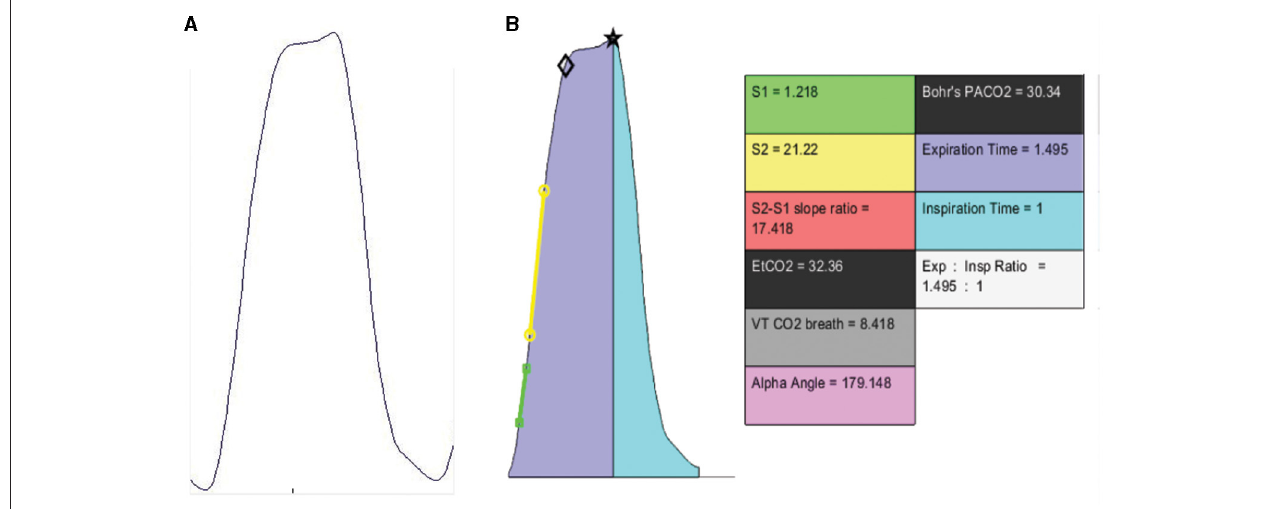
FIGURE 3 | (A) Raw capnographic signal. (B) “Digitized” signal with derived capnometric parameters. The black star and diamond are MATLAB derived plot coordinates for EtCO2 and Bohr’s PACO2 respectively.